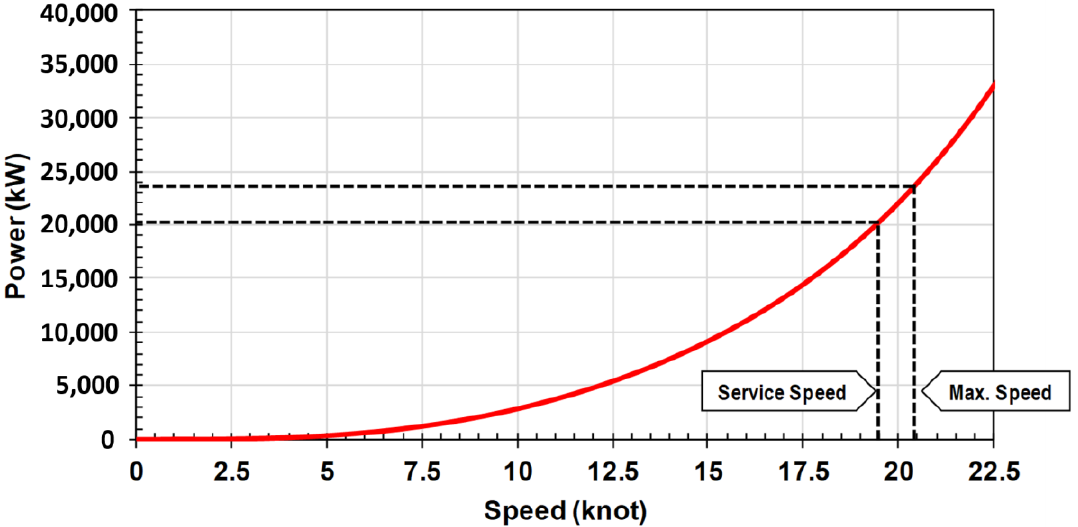
Figure 1. Power prediction using Holtrop methods.